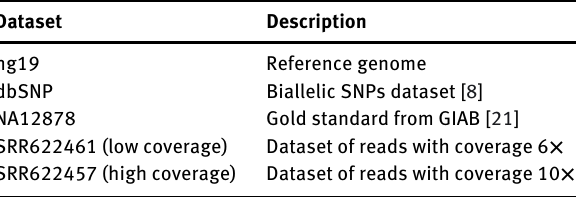
Table 1: Resources and datasets used for